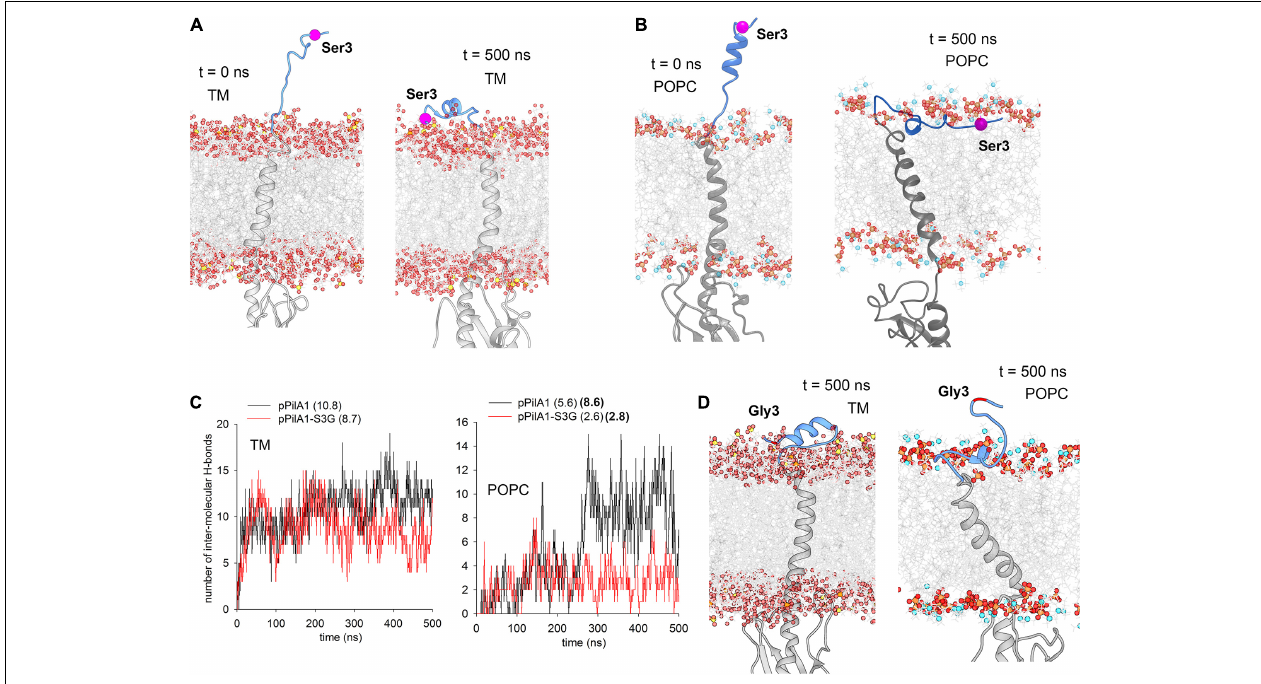
FIGURE 8 | MD simulations of the Synechocystis pPilA1 and pPilA1-S3G proteins in a membrane bilayer. (A) Snapshots of the initial (0 ns) and the representative final (500 ns) conformation of pPilA1 in the TM ( Supplementary Video 1 ). The signal peptide of pPilA1 is depicted in blue, the rest of the protein is in gray. Oxygen atoms in lipid molecules are shown as red spheres, sulfur (in sulfoquinovosyl diacylglycerol) as yellow spheres, phosphate atoms as orange spheres and nitrogen atoms (in POPC) as blue spheres. The position of Ser3 is highlighted by a magenta ball. Water molecules were omitted for clarity. (B) A snapshot of the initial (0 ns) and representative final (500 ns) positions of pPilA1 in the POPC bilayer ( Supplementary Video 2 ). (C) Number of intermolecular hydrogen bonds between the pPilA1 signal peptide and TM or POPC lipid molecules for each frame (0–500 ns) of the MD simulation compared with the pPilA1-S3G. Numbers in parentheses indicate an average number of hydrogen bonds per frame formed during the simulation, numbers in bold show the number of hydrogen bonds for the period between 250–500 ns. See Supplementary Figures 8A,B for the description of hydrogen bonds between the lipid polar region and the pPilA1 signal peptide. (D) Representative final positions of PilA1-SG3 in the TM and POPC bilayer ( Supplementary Videos 3 , 4 ); see also Supplementary Figures 8C,D for the initial positions of the pPilA-S3G mutant